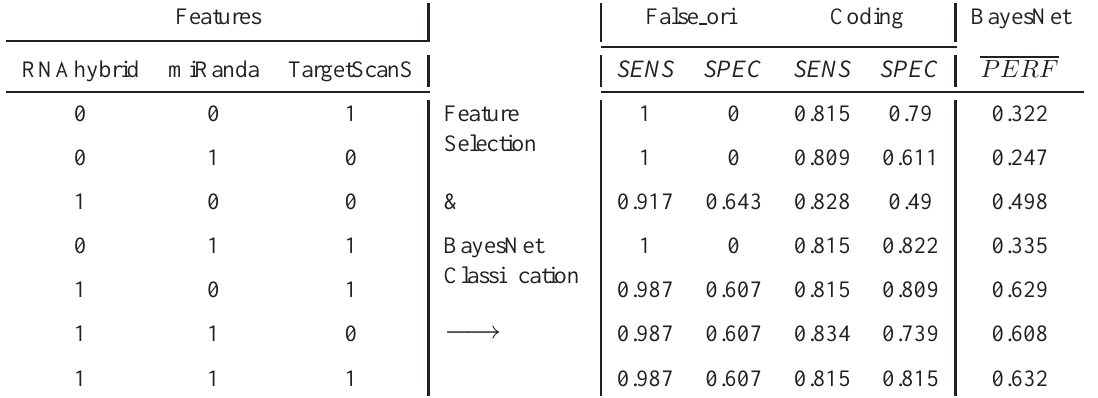
Table 5: Performance of Bayesian Network classification on different features. In the Features column, 1 represents that the features from this algorithm are selected for the machine